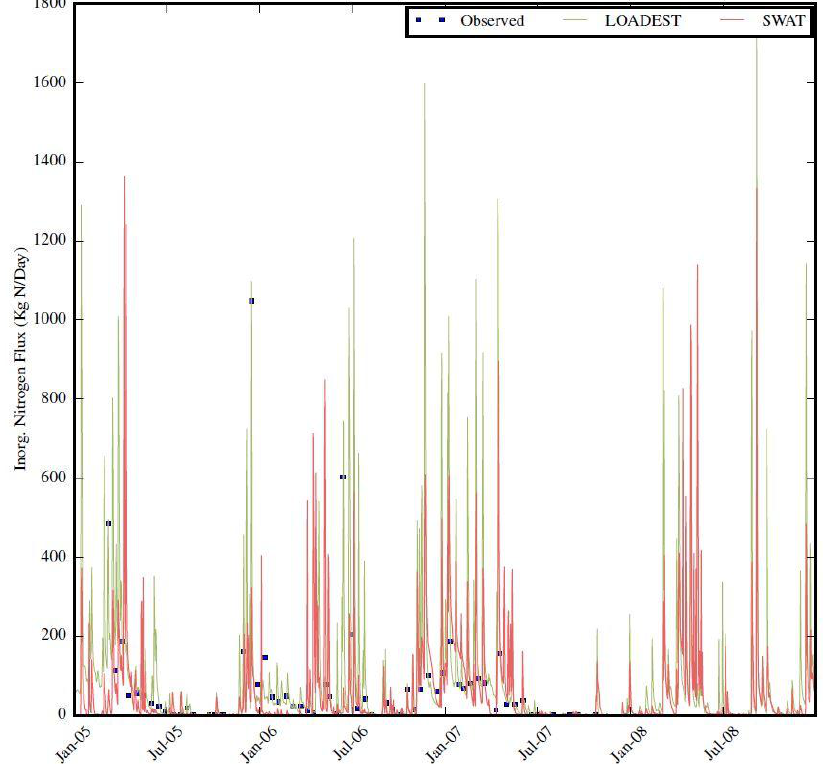
Figure 4. Comparison of observed daily inorganic nitrogen load at the Environmental Protection Agency (EPA) station J0770000 with LOADEST and SWAT simulated inorganic nitrogen load.